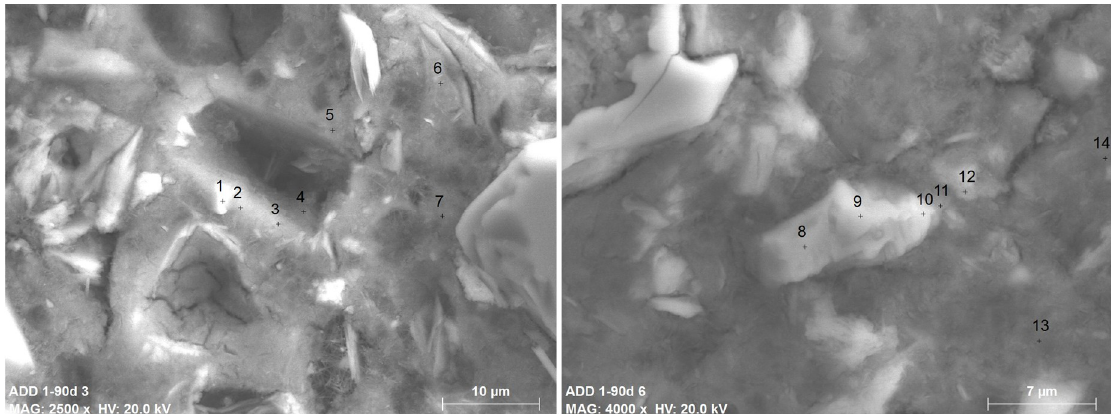
2 , Na 2 O and Al 2 O 3 , which agree with